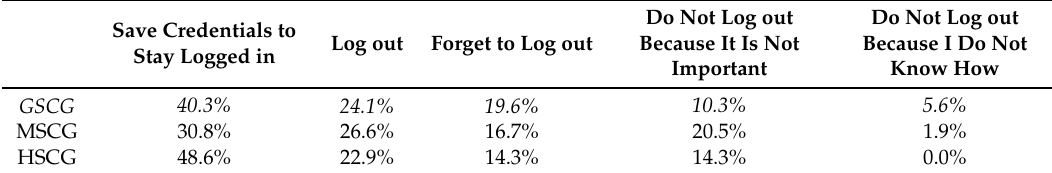
Table 6. As soon as you have finished using an application, you..?